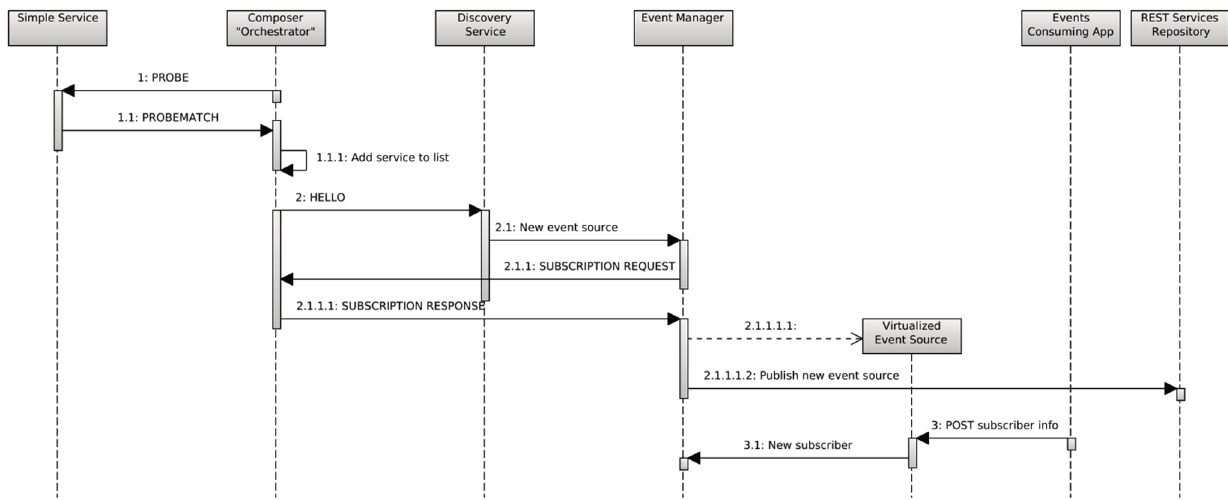
Figure 3. Composition of a virtual event source.